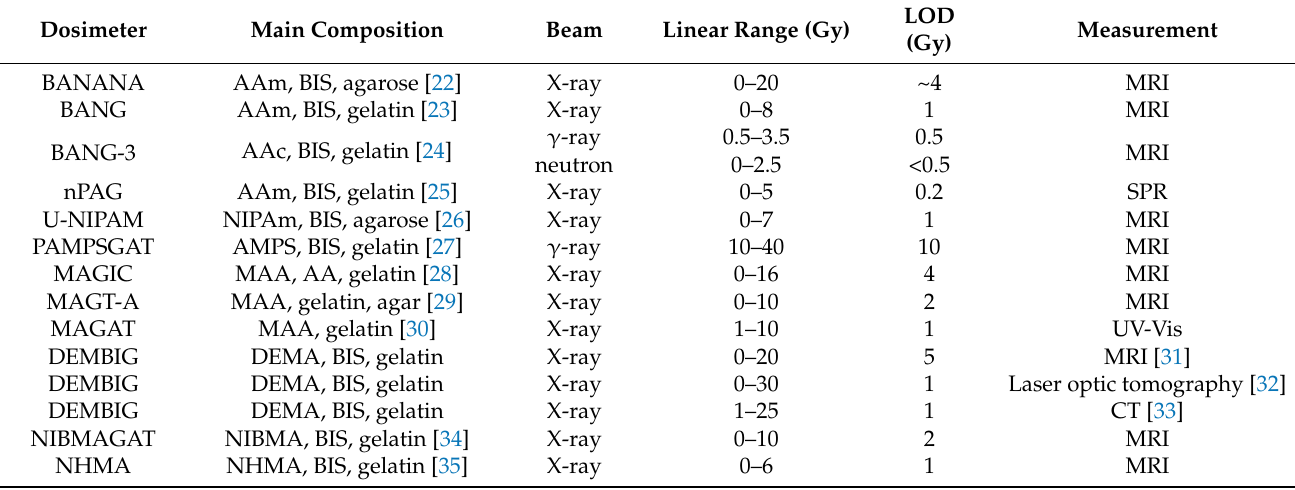
Table 1. Characteristics of representative polymer